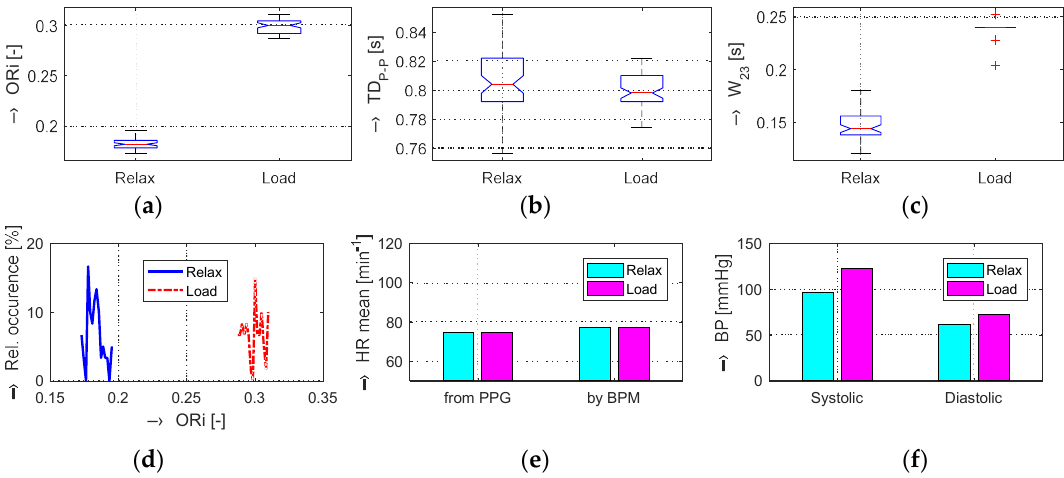
Figure 6. Changes in evaluated human cardiovascular parameters determined in Relax and Load phases with raising BP values and practically unchanged HR values: box-plot of basic statistical parameters of ( a ) ORi, ( b ) TD P-P , and ( c ) W 23 values; ( d ) comparison of histograms of ORi values; ( e ) bar-graphs of HR determined from the PPG signal and measured by the BPM device; ( f ) comparison of systolic and diastolic blood pressure values; female person.